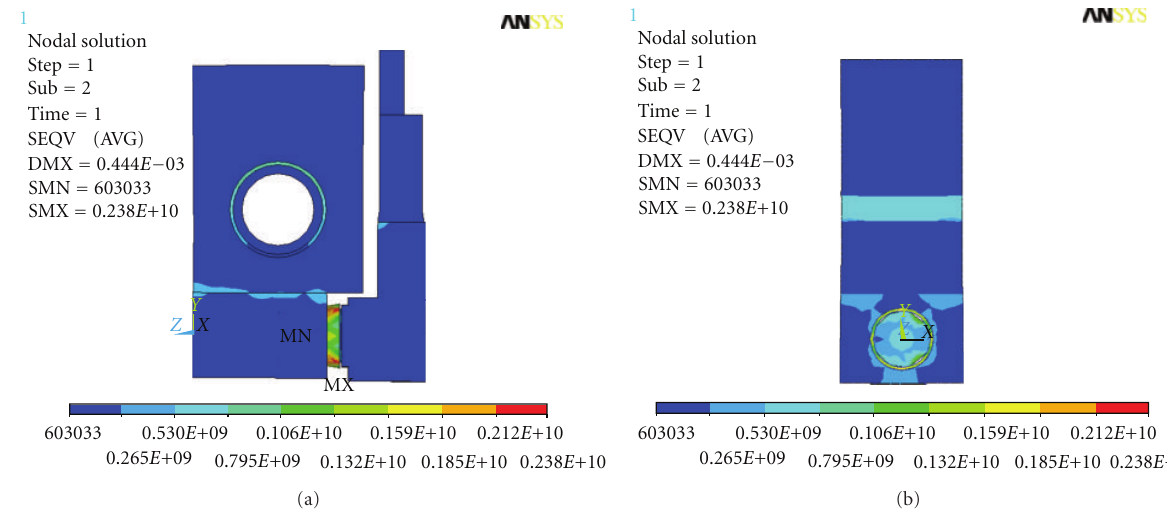
Figure 9: The 211 s thermal stress field of LP-CM (a) front view and (b) cross section.